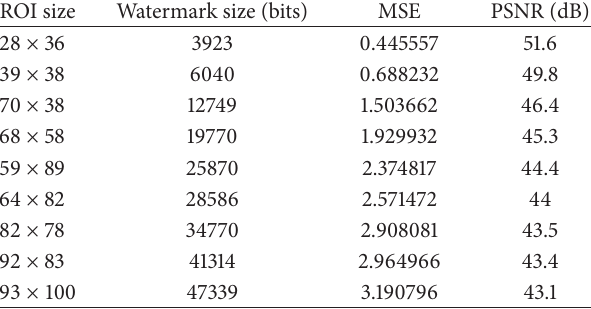
Table 2: Embedding performance of PET image of size 128 × 128 .